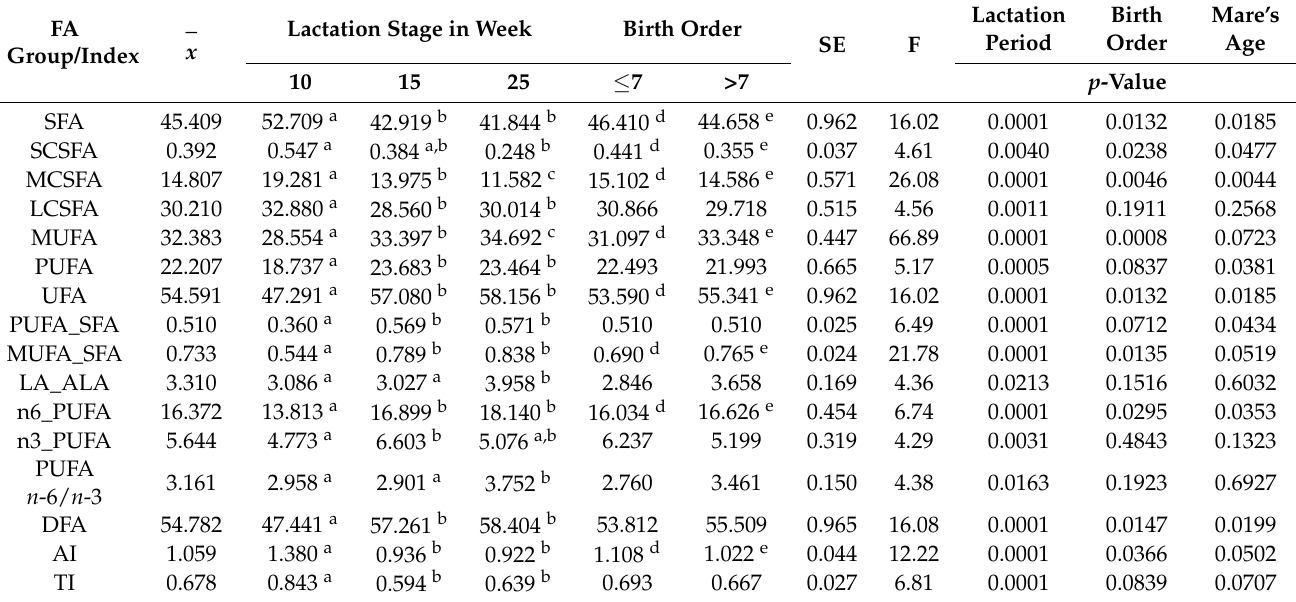
Table 3. Effect of lactation stage, birth order, and mares’ age on values of healthy fatty acid indices of mare’s milk (g/100 g total fatty